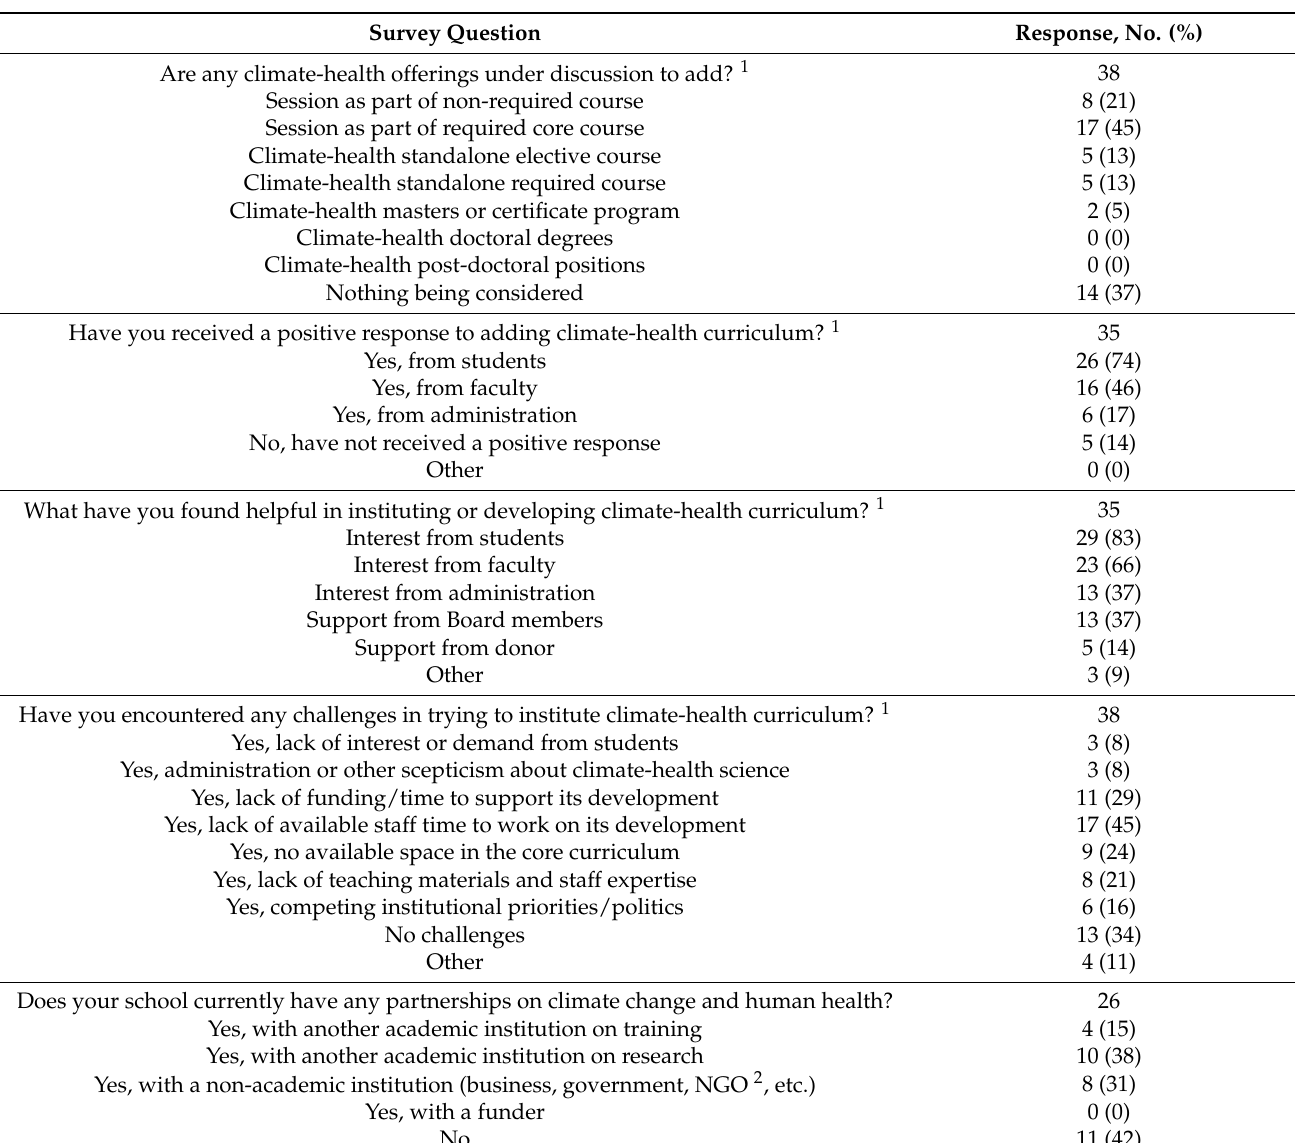
Table 2. Challenges, responses, and future plans for climate-health